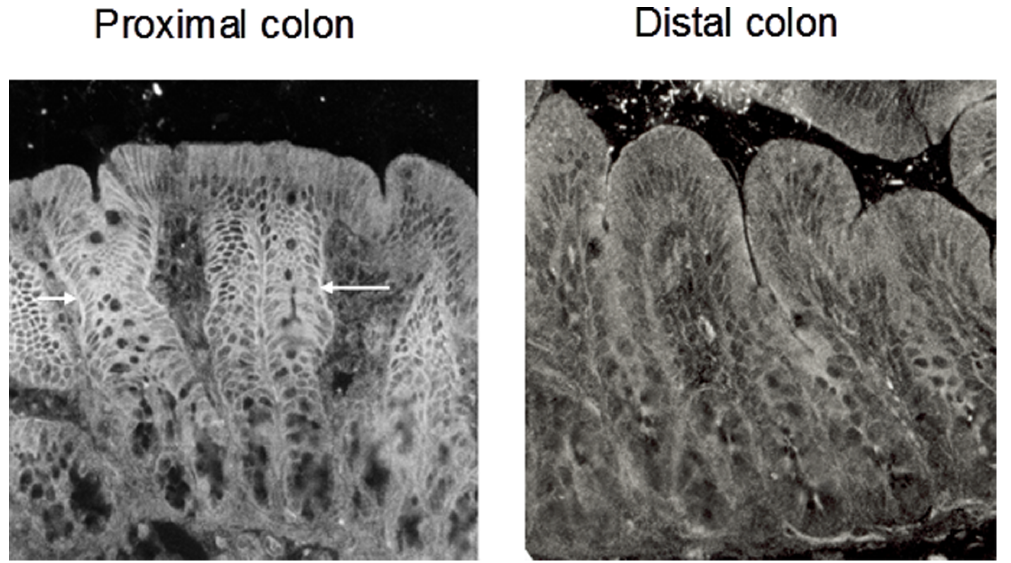
Figure 3. Immunocytochemical localization of NBCe1-like proteins in rat proximal and distal colon. [ A ] Rat proximal colon demonstrates strong basolateral staining for NBCe1 in epithelial cells of the mid-crypt region (arrows) and weaker staining in surface cells. [ B ] Rat distal colon shows no localization of NBCe1 in the epithelial cells. Magnification 40x.